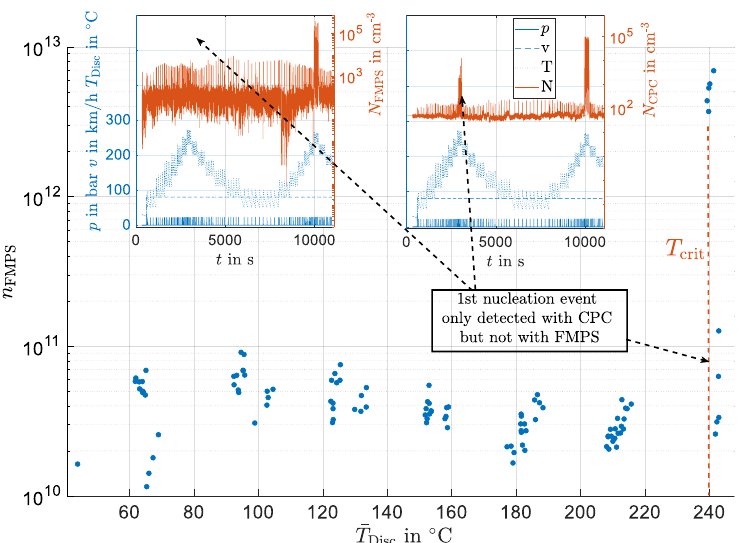
Figure A2. Total number of particles emitted per brake event plotted versus the average disc temperature during the brake event for pad material with inorganic binder analog to Figure 6. In addition to Figure 6, the time series of FMPS and CPC concentration is shown to visualize that the first nucleation event was only detected by the CPC but not by the FMPS, which has a higher detection limit than the CPC regarding the particle diameter. The second triangle was aborted due to the dynamometer’s